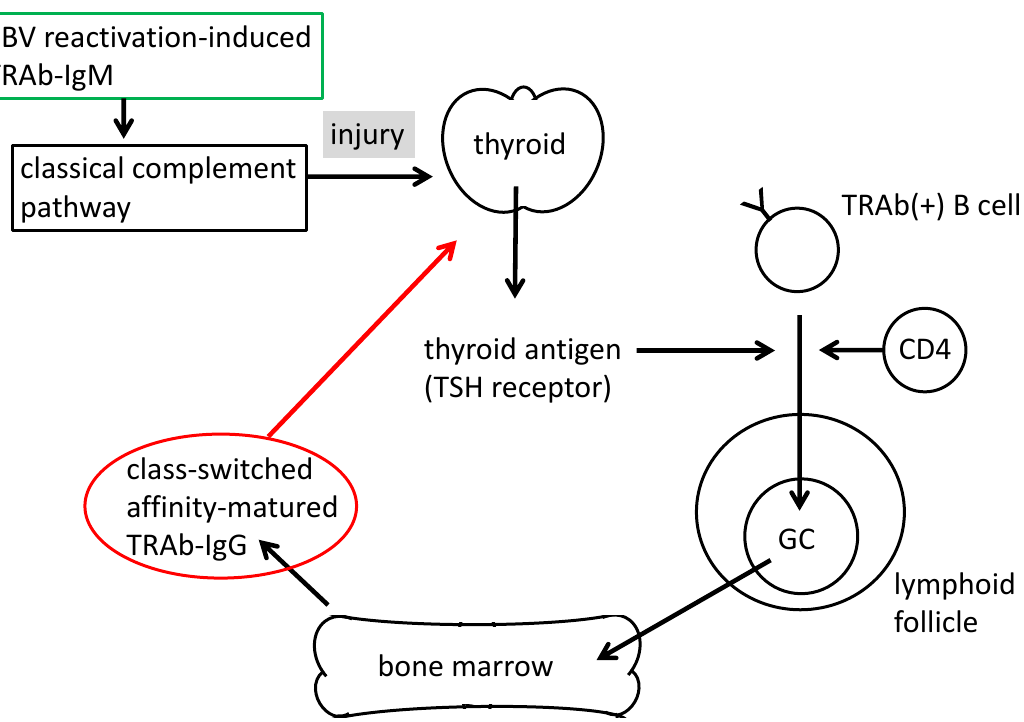
Figure 4. Tissue injury by the TRAb-IgM-activated complement system and production of high a ffi nity TRAb-IgG. EBV reactivation-induced TRAb-IgM may injure thyroid follicular cells through the activation of the classical complement pathway. Thyroid debris may be removed to the circulation and incorporated by B cells in lymphoid tissues. B cells digest and present an antigen of the TSH receptor to cognate T cells, activating the CD40 signal, and proliferated B cells then form germinal centers to produce a ffi nity-matured TRAb-IgG, which may develop and exacerbate Graves’ disease (red